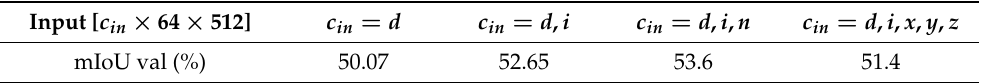
Table 1. Comparison of different input channels for the SalsaNext architecture. All results are without any post-processing steps. The projection of the coordinates x , y , and z does not bring any advantages, but the use of the surface normals n slightly increases the